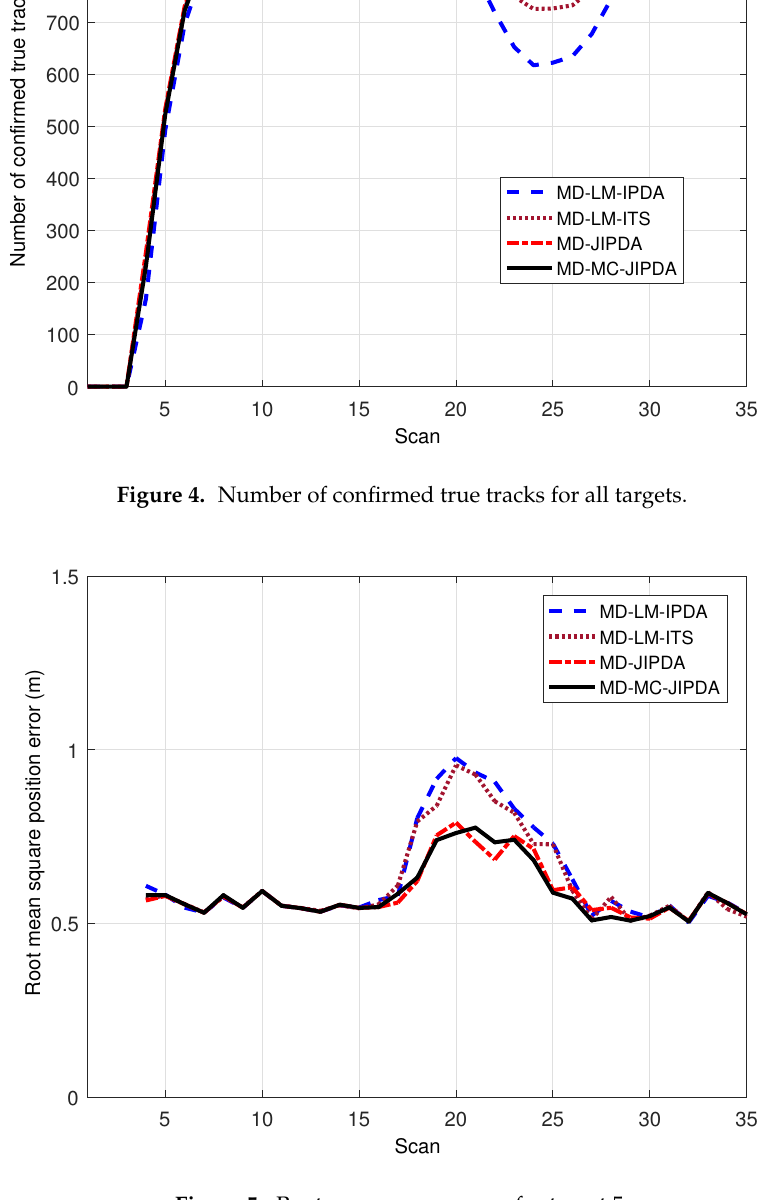
Figure 5. Root mean square error for target